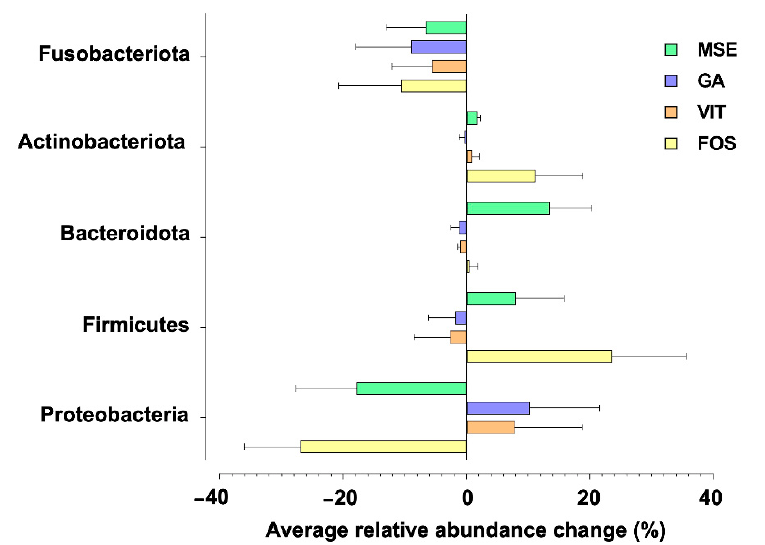
Figure 2. Phylum-level changes in the gut microbiota upon fermentation with mung bean seed coat extract (MSE), gallic acid (GA), vitexin (VIT), and fructo-oligosaccharide (FOS), compared with no added substrate (control; CON) following 24 h fecal fermentations. Only taxa with relative abundances higher than 0.5% were included.